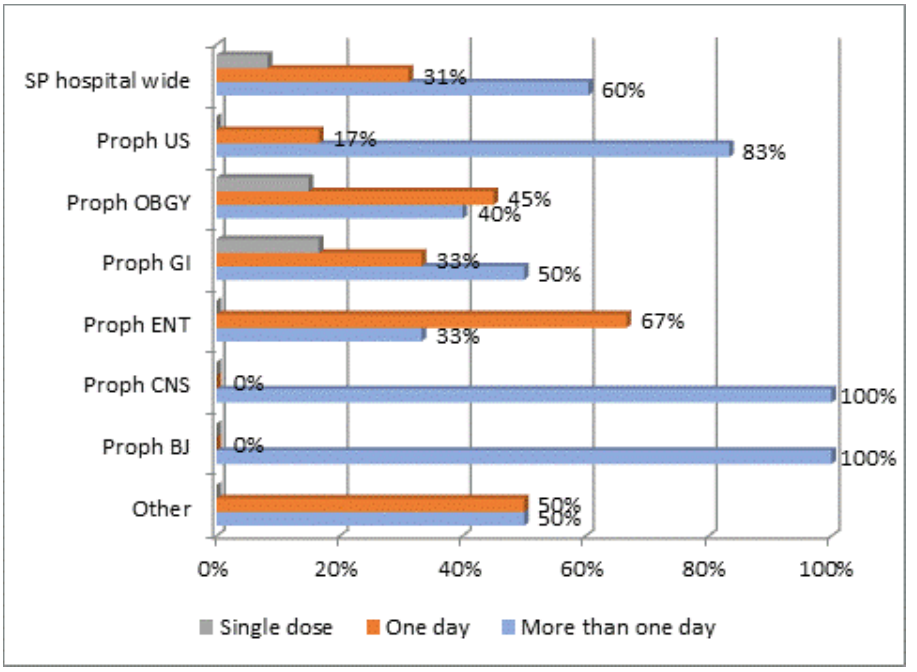
Figure 1. Duration of antimicrobial surgical prophylaxis (SP) in adults (N = 36) and children (N = 5) according to the type of surgical procedure.